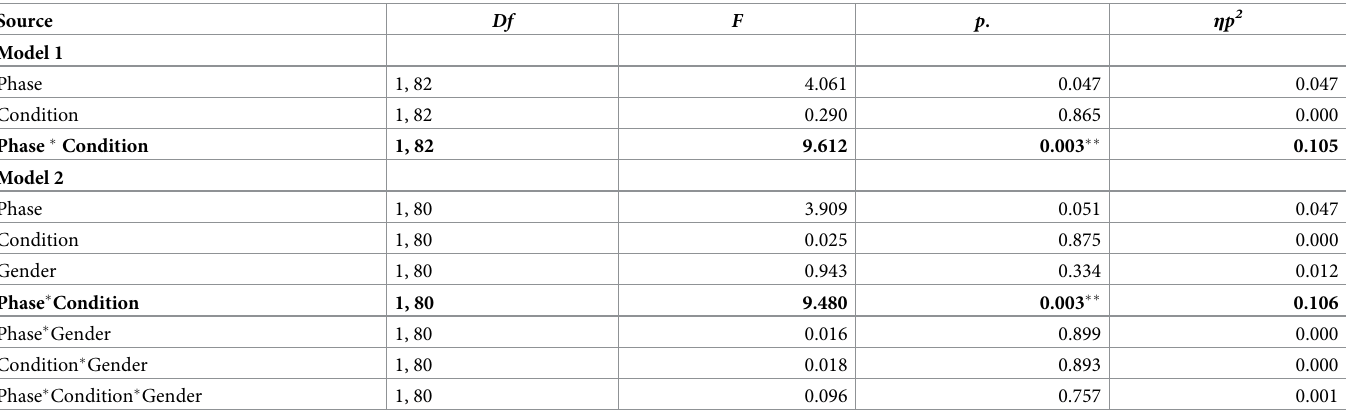
Table 10. Tabulated values for mixed ANOVA with phase (pre- versus post- manipulation preference for muscularity scores) as the repeated measures variable and condition (condition A versus condition B) as the between-participants factor (Model 1) with gender added as an additional between-participants factor (Model 2). Critical tests of our hypotheses are shown in